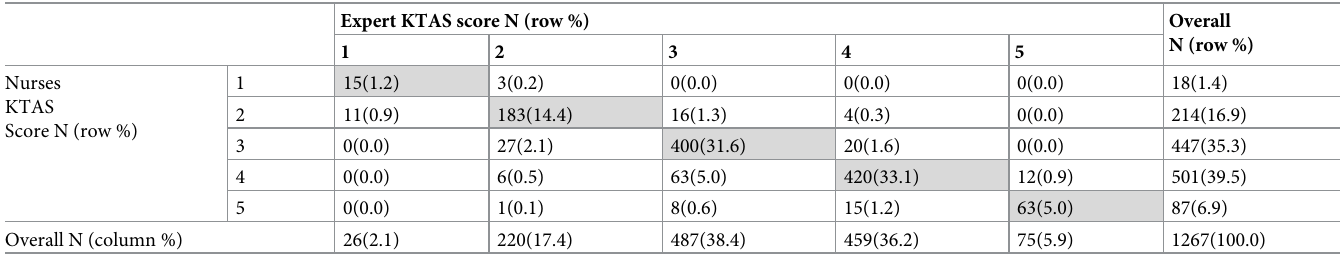
Table 2. Agreement between emergency nurses and experts.